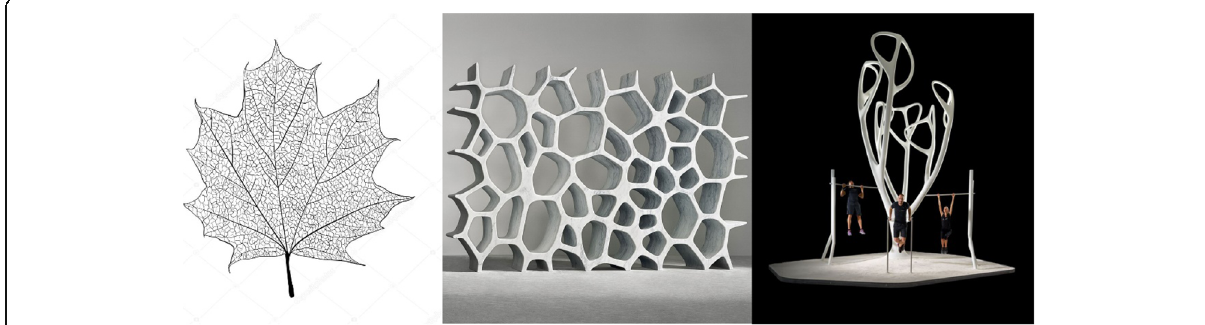
Fig. 2 Three steps of biomimetic approach for the example “ My Equilibria ” , an urban furniture design (source: http://www.myequilibria.com/ myequilibria/ and An đ ela D. Miti ć